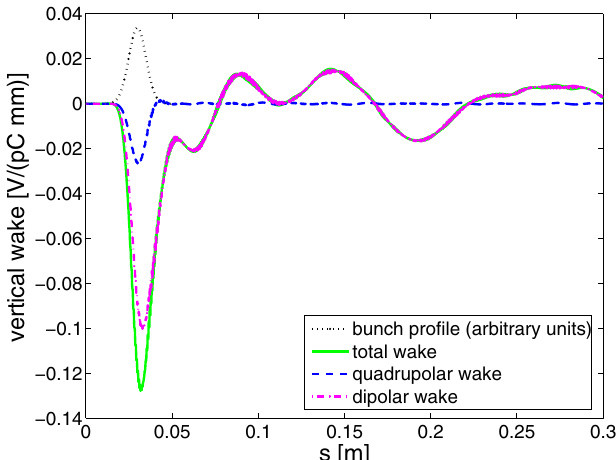
FIG. 7. (Color) Decomposition of the total vertical wake (green) in its dipolar part (magenta) and quadrupolar part (blue). The black dashed curve is the electron beam